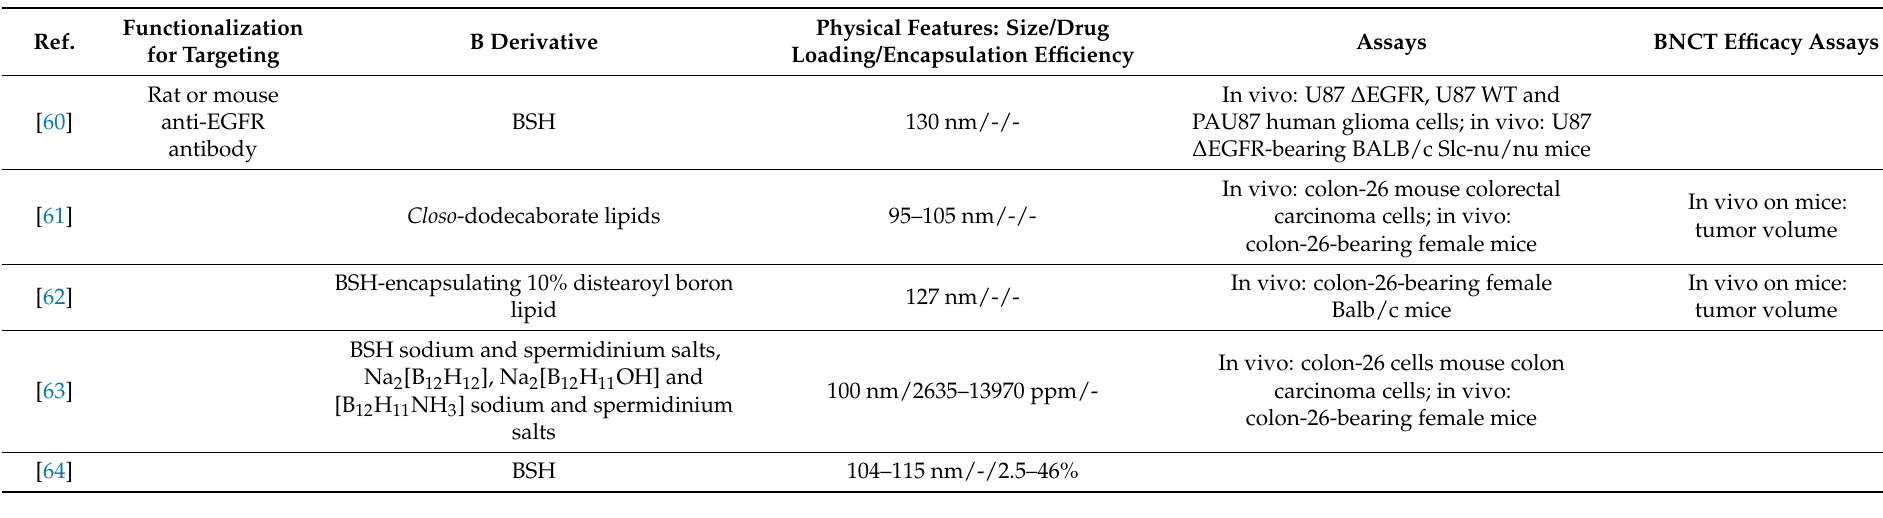
Table 2. Other NPs for BNCT applications, classified by the type of nanocarrier.